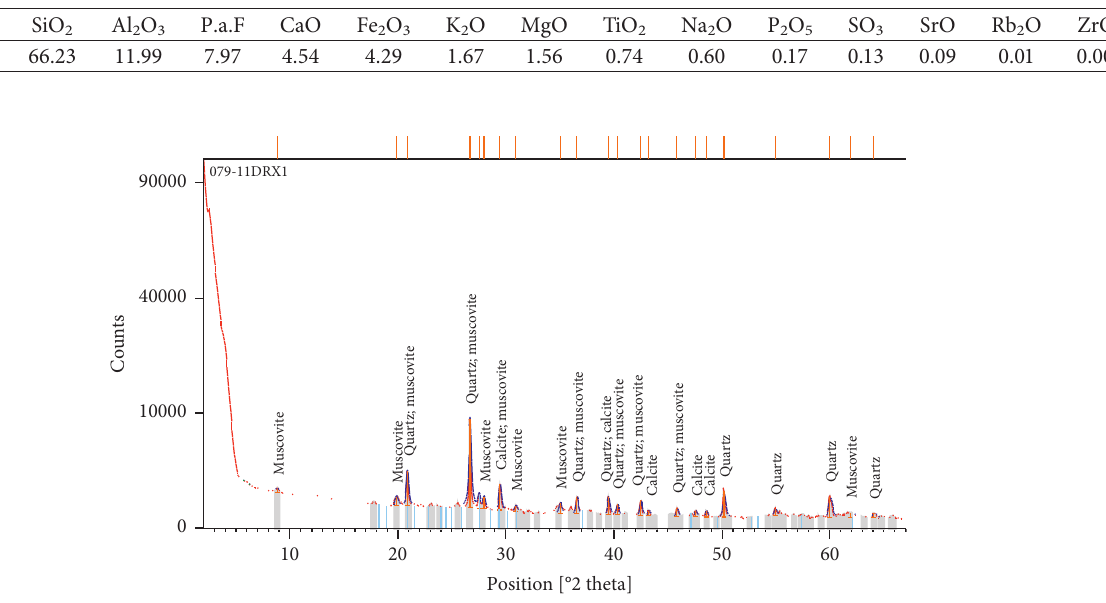
Table 2: Chemical composition by carrier X-ray fluorescence spectroscopy.